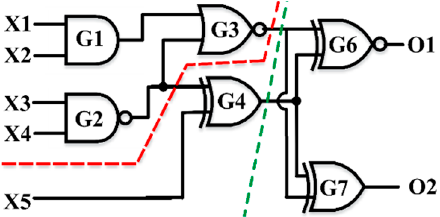
Figure 4. Demonstration of the min-cut partitioning algorithm using a simple example circuit.